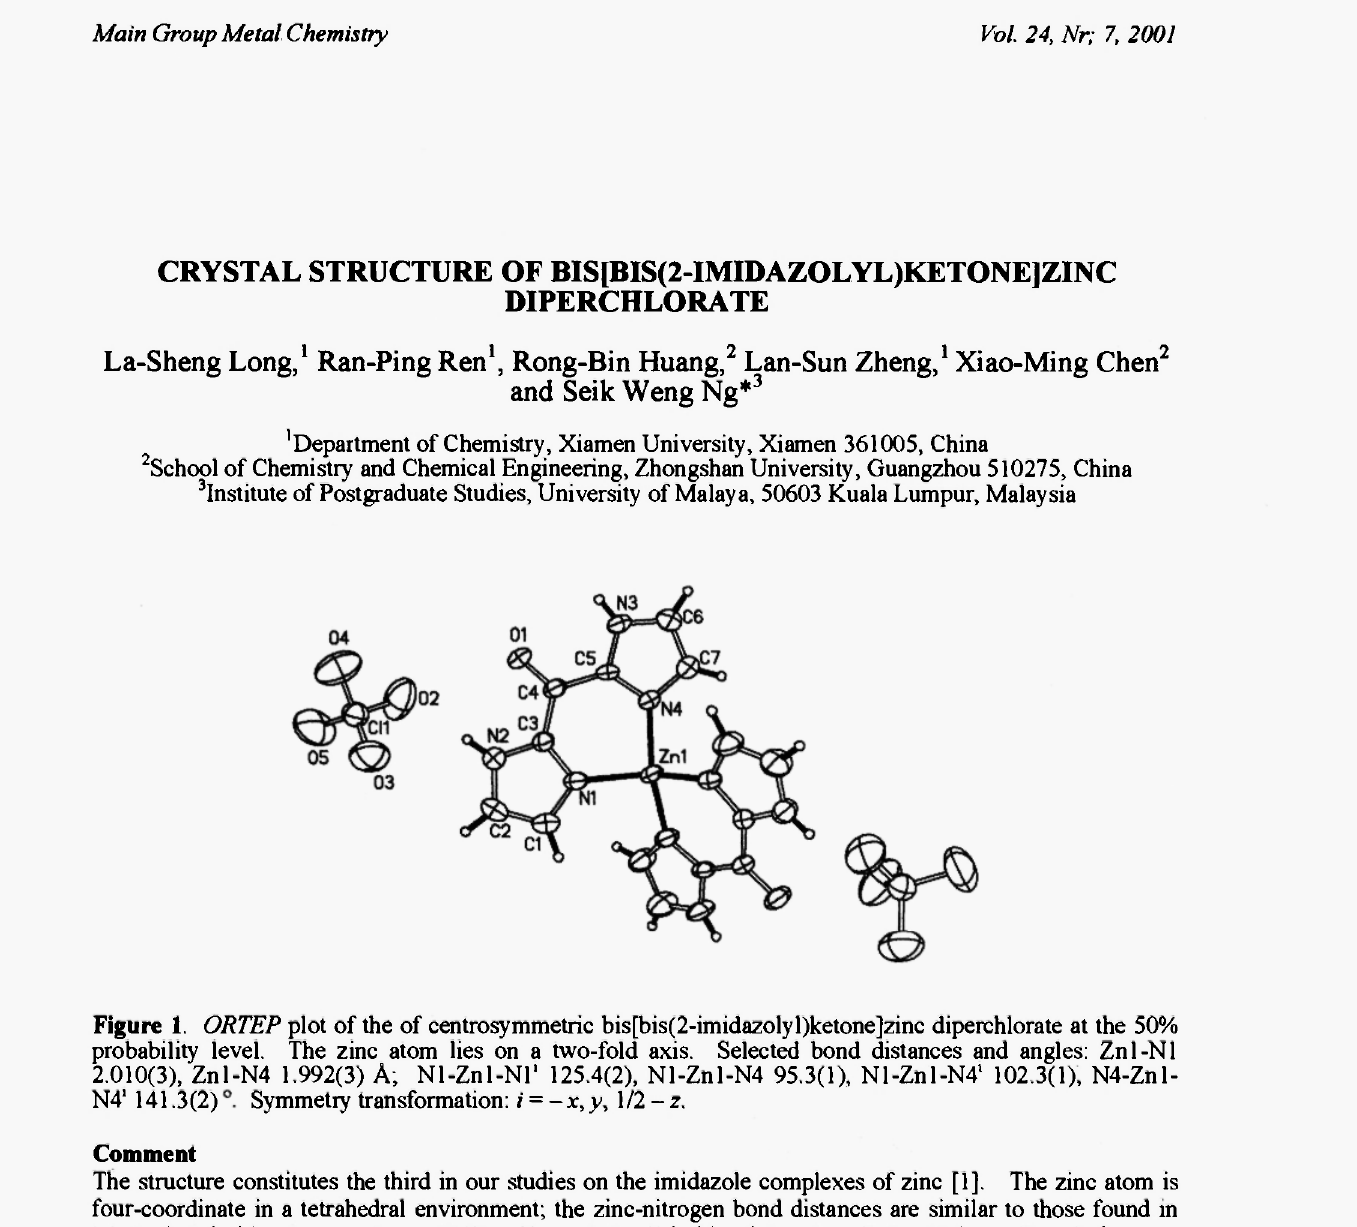
Figure 1. ORTEP plot of the of centrosymmetric bis[bis(2-imidazolyl)ketone]zinc diperchlorate at the 50% probability level. The zinc atom lies on a two-fold axis. Selectol bond distances and angles: Znl-Nl 2.010(3), Znl-N4 1.992(3) A; Nl-Znl-Nl" 125.4(2), Nl-Znl-N4 95.3(1), Nl-Znl-N4' 102.3(1), N4-Znl- N4 1 141.3(2)Symmetry transformation: i = -x,y, 1/2